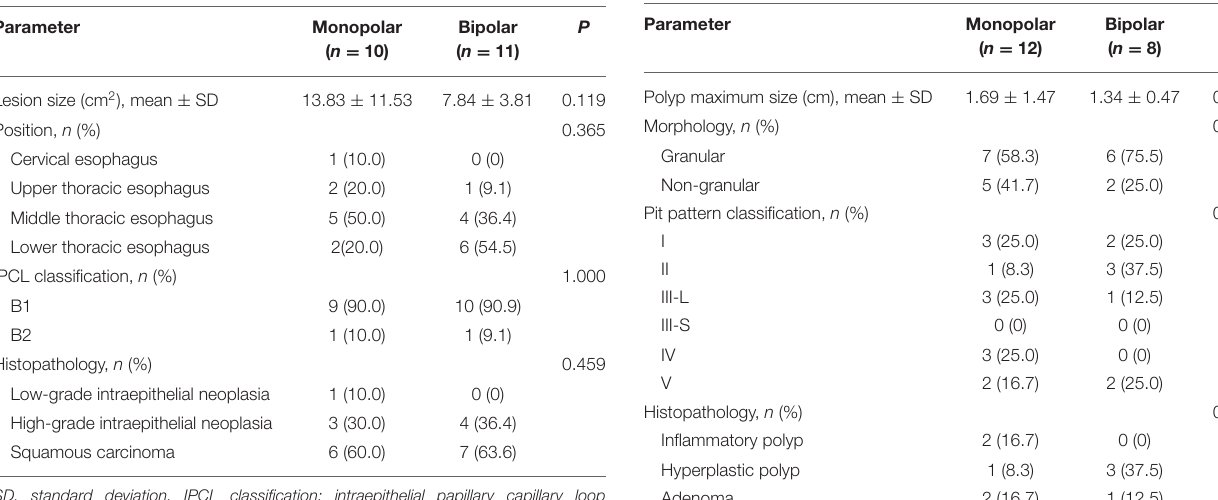
TABLE 4 | Characteristics of colorectal polyps in patients who underwent colorectal